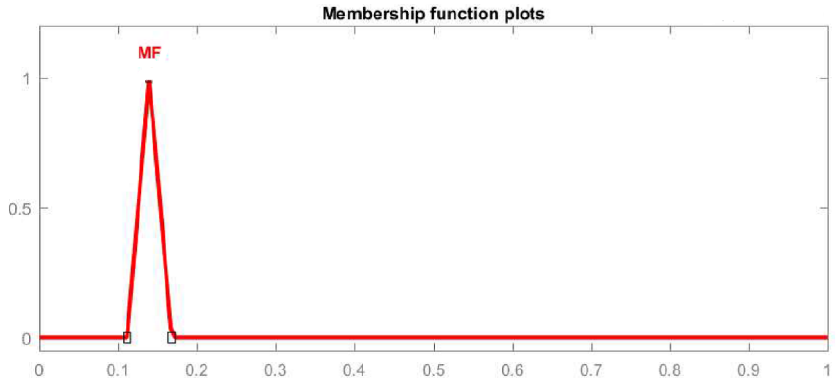
Figure 7. Membership function of linear consecutive 2-out-4: G system.